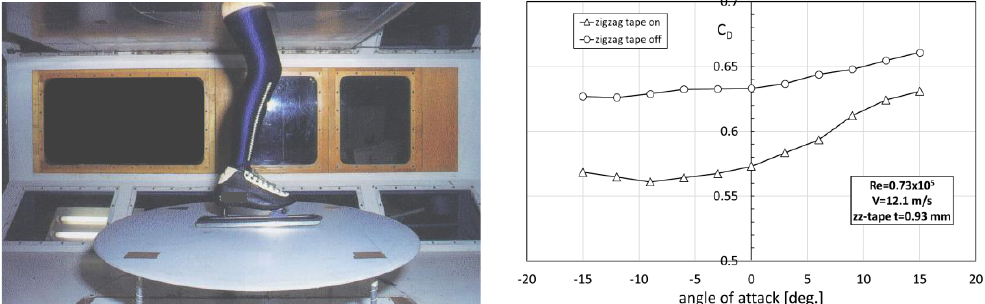
Figure 6. The drag variation with angle of attack of a small mannequin leg covered with a smooth skinsuit and 0.93 mm thick zigzag tape on the lower leg, at an azimuth angle of 55 degrees. Re = 0.73 × 10 5 . The measurements presented here were performed in the configuration of Figure 2, i.e., without the table and the skate.